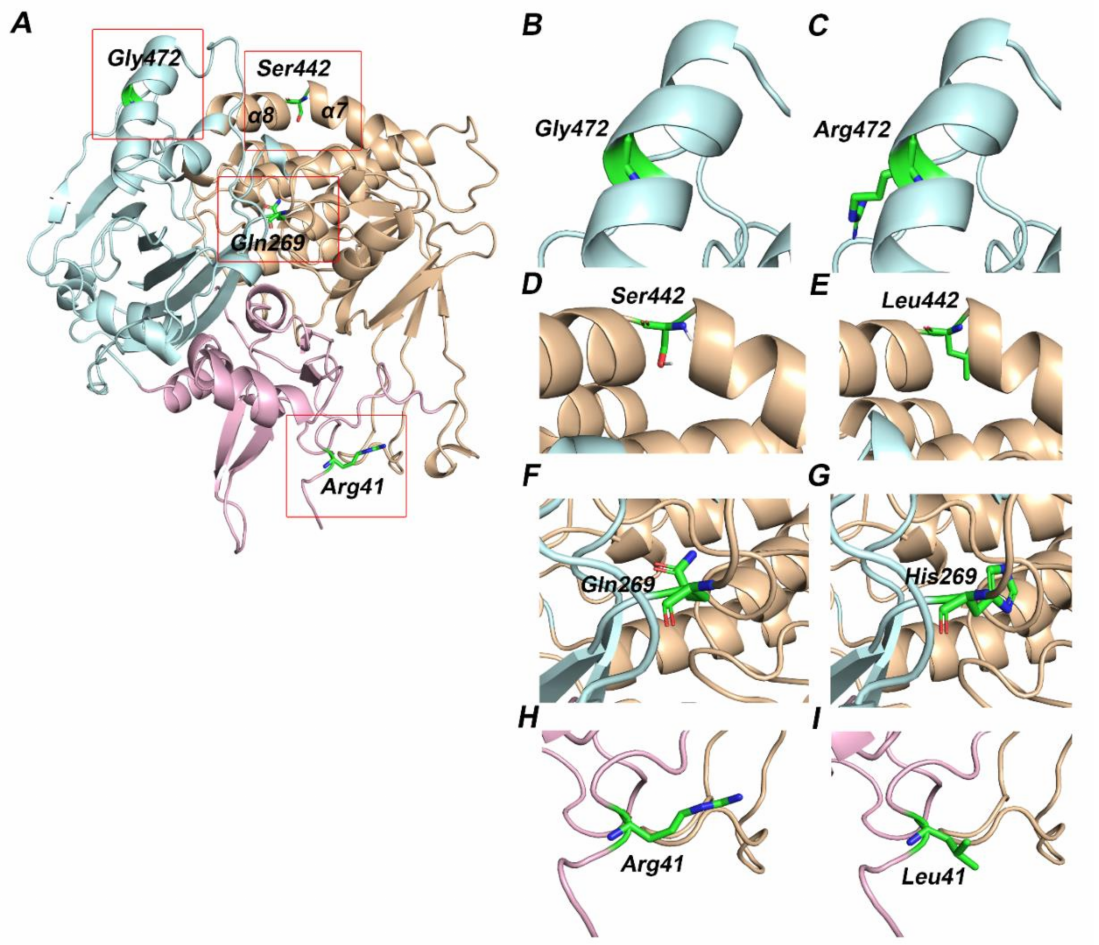
Figure 3. Three-dimensional structure of ETF-QO protein. The functional domains of ETF-QO protein—FAD (orange), UQ (cyan), and 4FE4S cluster (pink) are shown in cartoon representation and amino acids are shown in stick representation. The red boxed regions in A are magnified in the successive images. ( A ) Modeled structure of ETF-QO; ( B ) wild type Gly472; ( C ) mutant Arg472; ( D ) wild type Ser442; ( E ) mutant Leu442; ( F ) wild type Gln269; ( G ) mutant His269; ( H ) wild type Arg41; ( I ) mutant